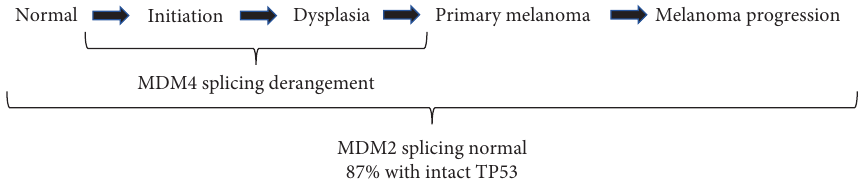
Figure 7: Model of melanomagenesis with the timeline of MDM2/4/p53 changes. Throughout progression from normal skin to metastatic disease, most cases retain wild-type p53 and demonstrate normal splicing and normal copy numbers of MDM2. In contrast, changes in MDM4 splicing are already in place in melanocytic nevi. MDM4 tends to be amplified in melanomas, and the profile of mRNA isoforms expressed is dramatically different from normal skin. This includes relatively high levels of